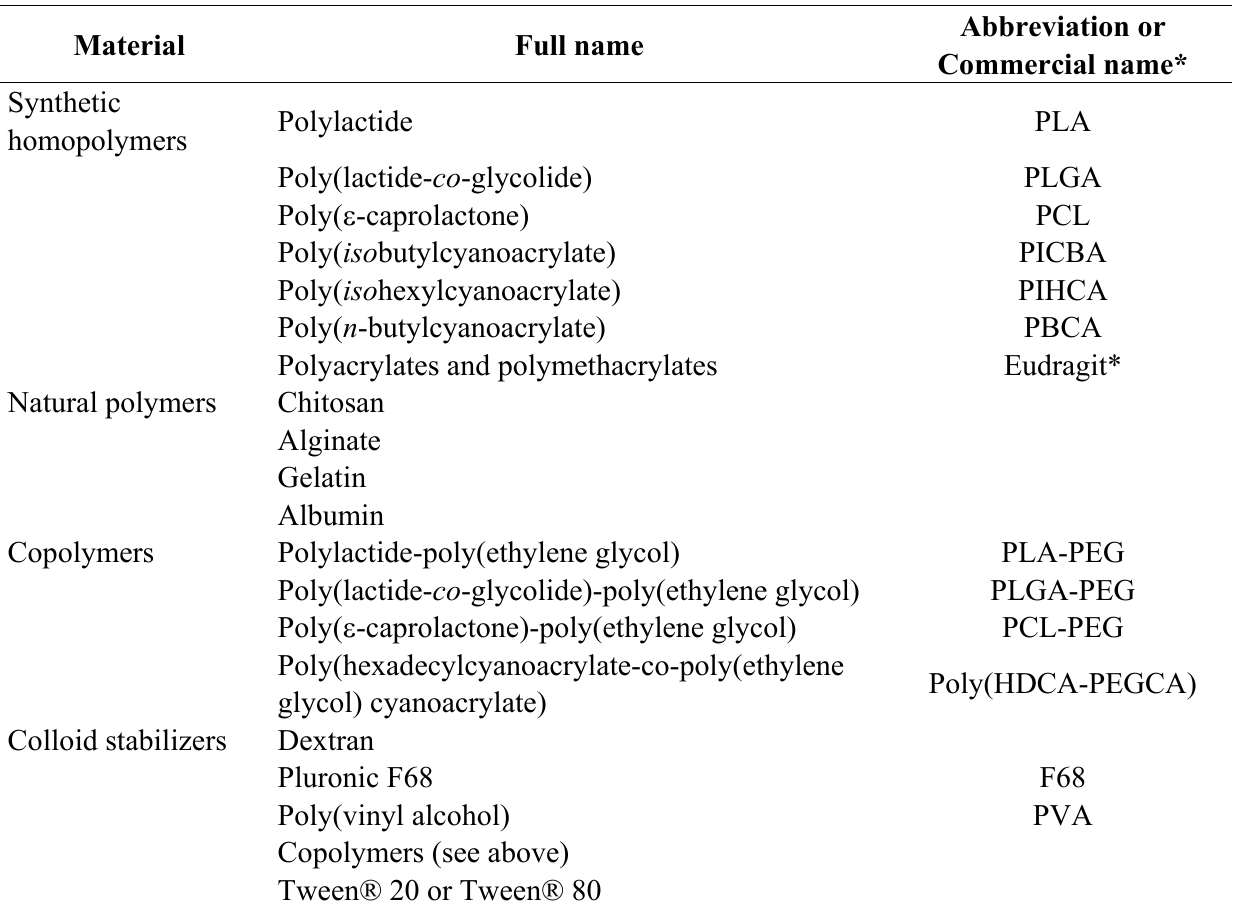
Table 2. Most widely used polymers constituting nanoparticles designed as drug carriers. With kind permission from Springer Science+Business Media: Pharmaceutical Research , Methods for the Preparation and Manufacture of Polymeric Nanoparticles, 26 , 2009 , 1027, Christine Vauthier and Kawthar